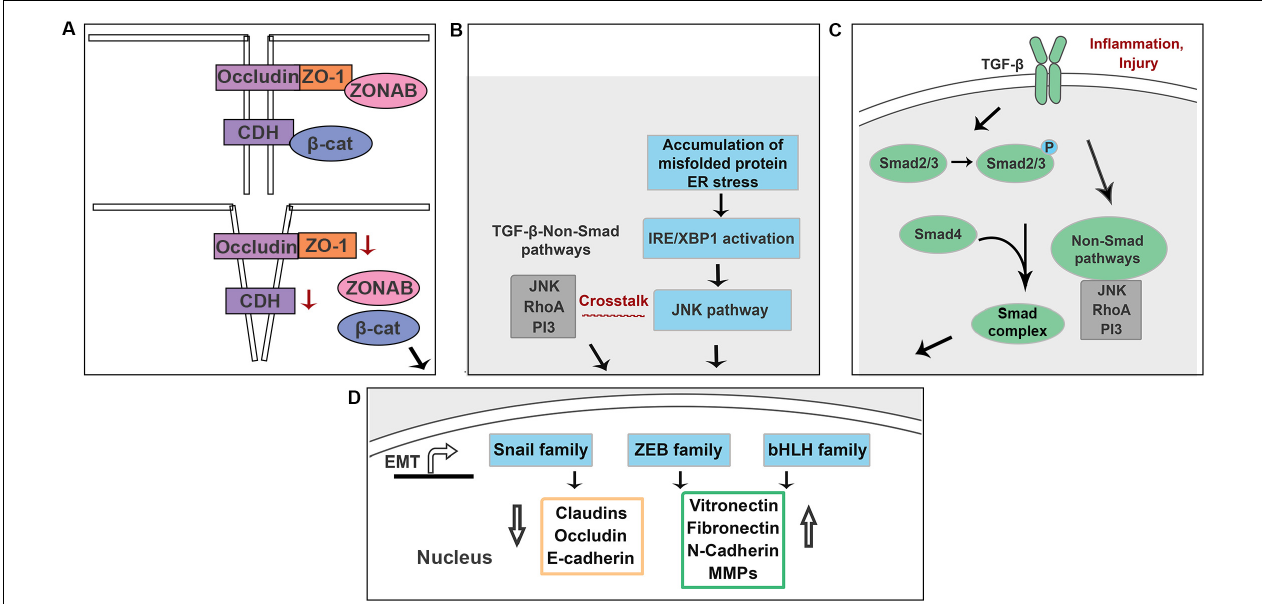
FIGURE 6 | Schematic illustration of the potential mechanisms underlying EMT in RPE cells. (A) Loss of ZO-1 and E-cadherin lead to a release of ZONAB and β -catenin. (B) Accumulation of misfolded proteins activate NK/p38-MAPK pathway that crosstalks with TGF- β -induced non-Smad pathways in an IRE-dependent manner. (C) Increased production of TGF- β is associated with inflammation and injury in RPE cells. (D) Above signals promote EMT by upregulating EMT drivers including Snail, Zeb and bHLH